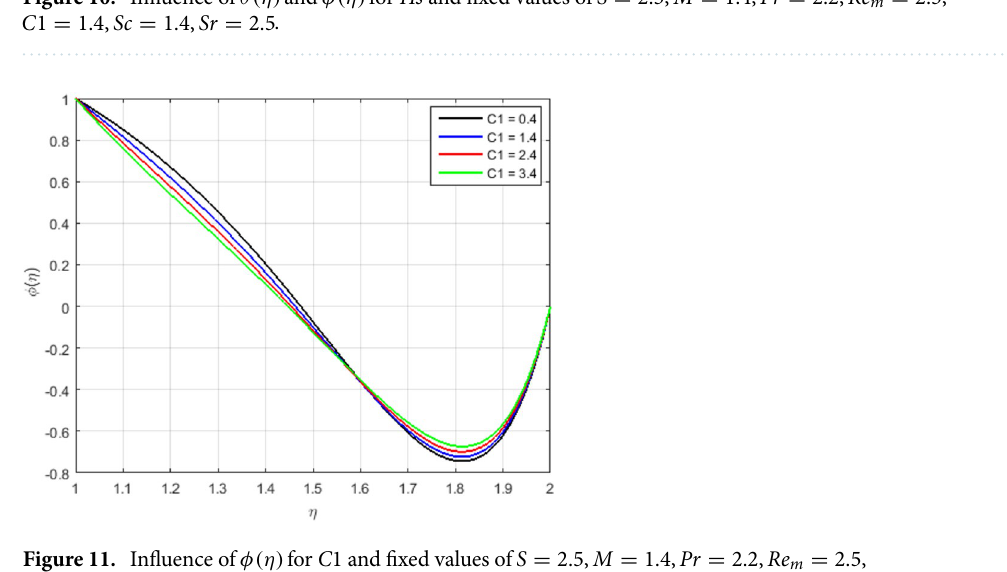
Figure 11. Influence of φ(η) for C 1 and fixed values of S = 2.5, M = 1.4, Pr = 2.2, Re m = 2.5, Hs = 1.2, Sc = 1.4, Sr = 2.5